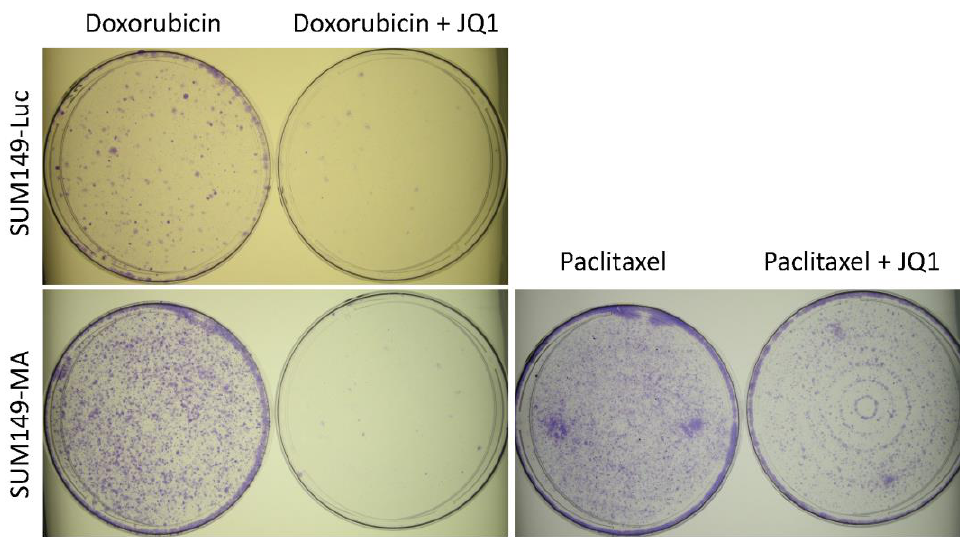
Figure 4. Inhibition of resistant cancer cells treated with a combination of chemotherapeutic drugs and JQ1. SUM149-Luc (top) and SUM149-MA (bottom) cells were treated with 100 nM of doxorubicin or 100 nM of doxorubicin plus 1 µM of JQ1, as indicated (left) for 6 days (which eradicated 99% of the cells in all dishes), and then allowed to recover in a drug-free medium for 11 days before being stained with crystal violet. A comparison of the number of colonies showed that the combination of JQ1 and doxorubicin eradicated more cancer cells in both cell lines than did doxorubicin alone. We also treated SUM149-MA cells with 5 nM of paclitaxel or 5 nM of paclitaxel plus 1 µM of JQ1, as indicated (right) for 6 days, and then allowed to recover in a drug-free medium for 7 days before crystal violet staining. Passage numbers: passage 6 for both cell lines.